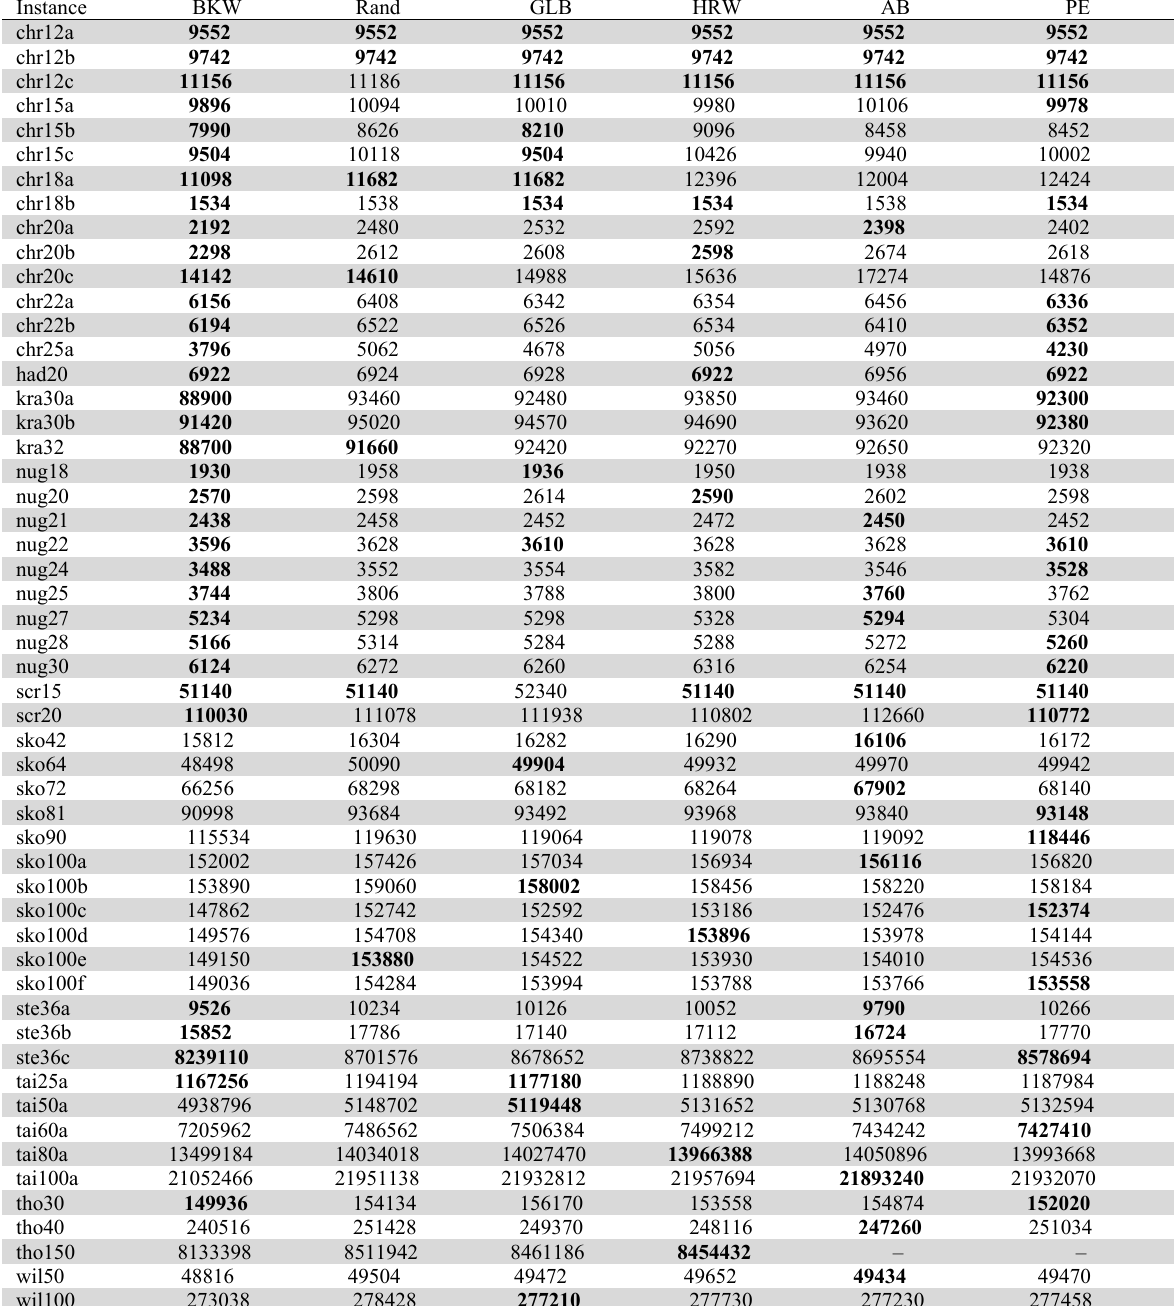
Best (minimum) results from the simulations. If the BKW is confirmed optimal, it is highlighted in bold. Also, in bold is the method that produced the best solution for the given instance.